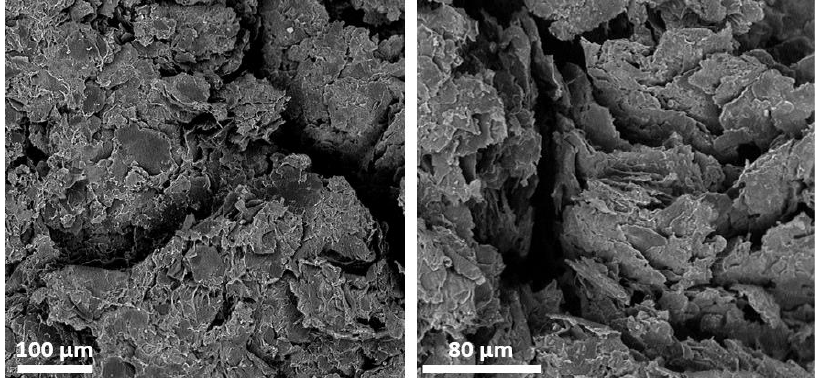
Figure 4. SEM images of composite fractures for 55 wt% (36.8 vol%) GNP sample.